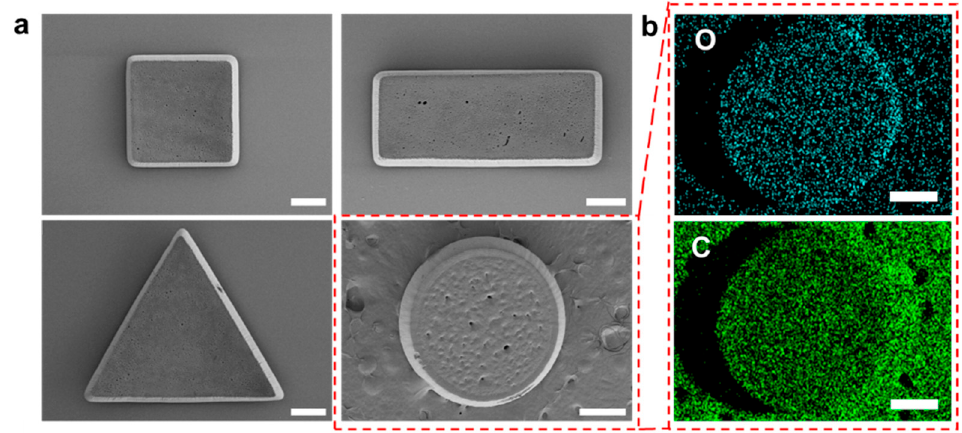
Figure 2. SEM–EDS images of the patterned PEGDA: ( a ) SEM images of the patterned PEGDA for various shapes, namely square (40×), triangle (40×), rectangular (30×), and circular (30×); ( b ) EDS images of circular-shaped solid drugs (scale bar: 500 µm).